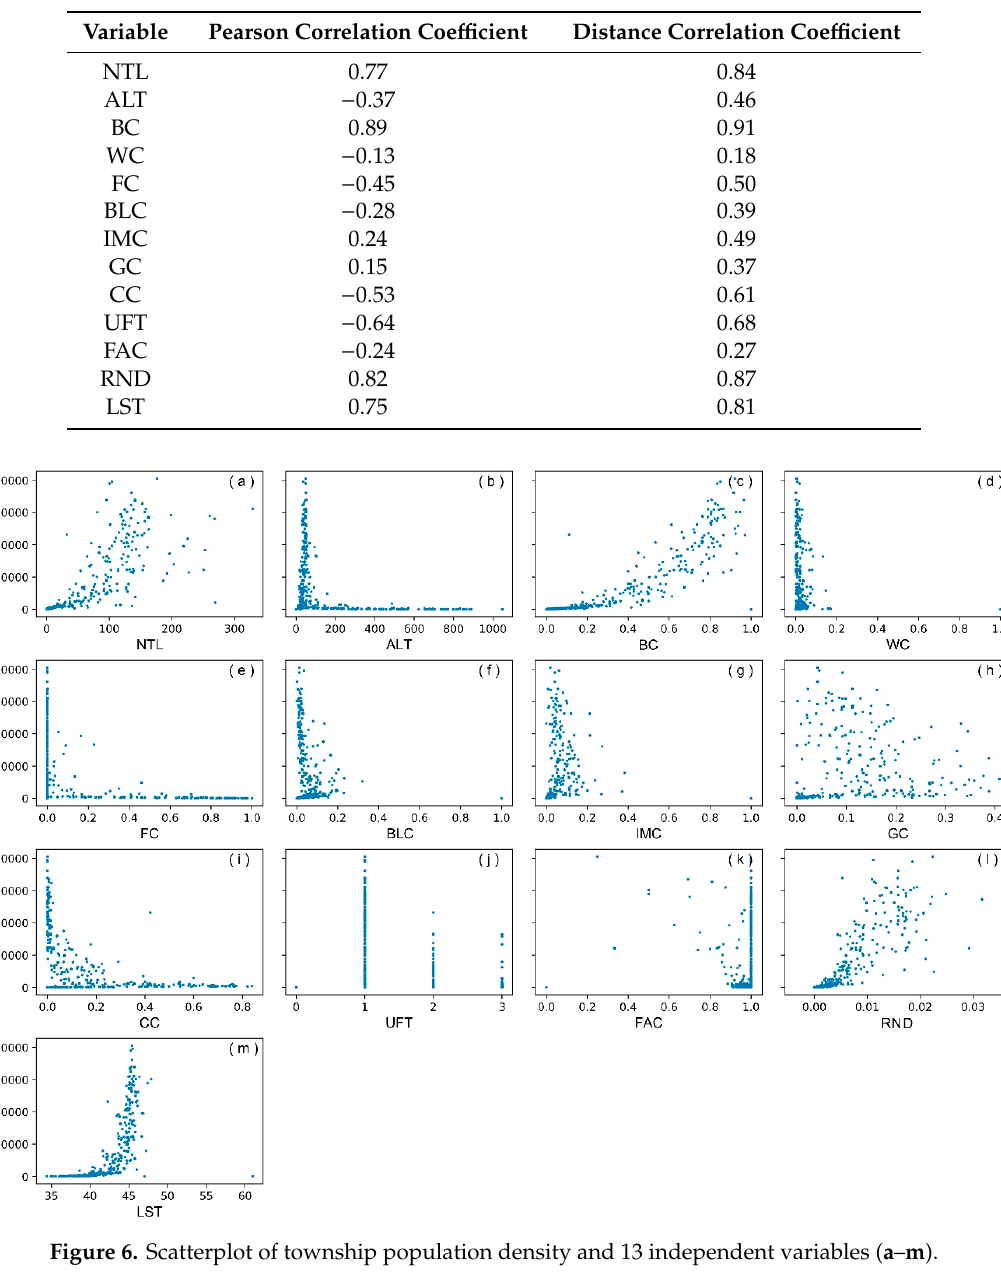
Table 3. Correlation coe ffi cients between independent variables and population density.